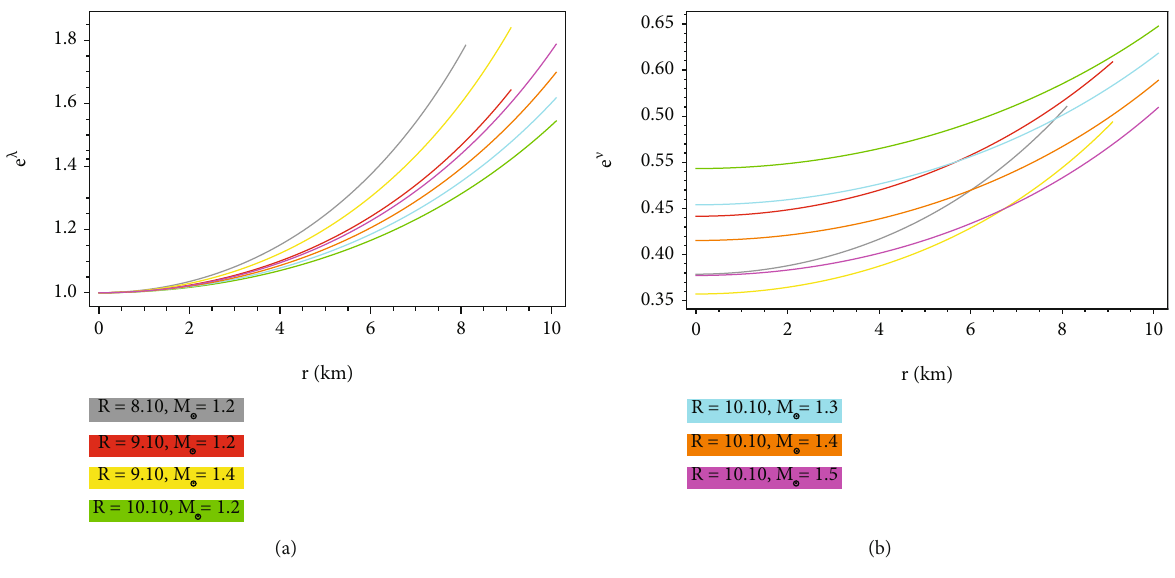
Figure 1: Variation of g